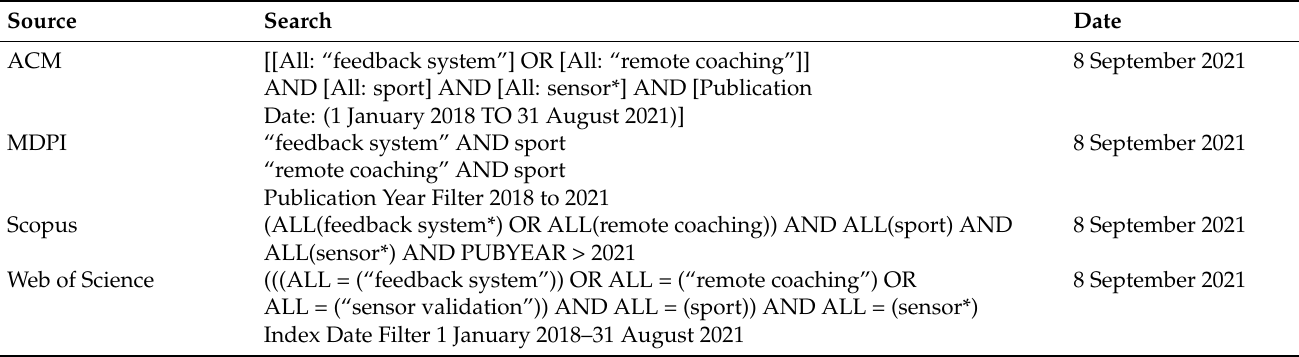
Table 3. Primary sources used for the